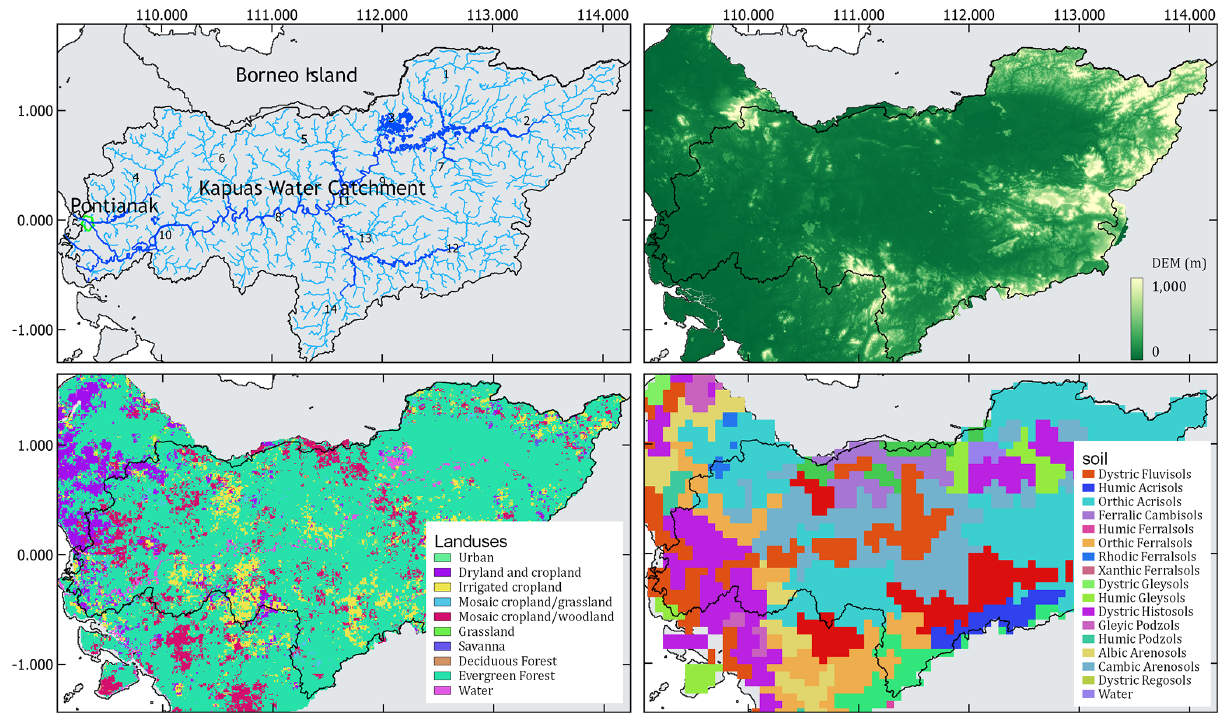
Figure 2. Kapuas water catchment area (upper left), digital elevation map (DEM) (upper right) retrieved from SRTM (Farr et al., 2007), land cover maps (lower left) retrieved from CGLOPS1 (Buchhorn et al., 2020), and soil type maps (lower right) retrieved from FAO (Sanchez et al., 2009) for the Kapuas River catchment